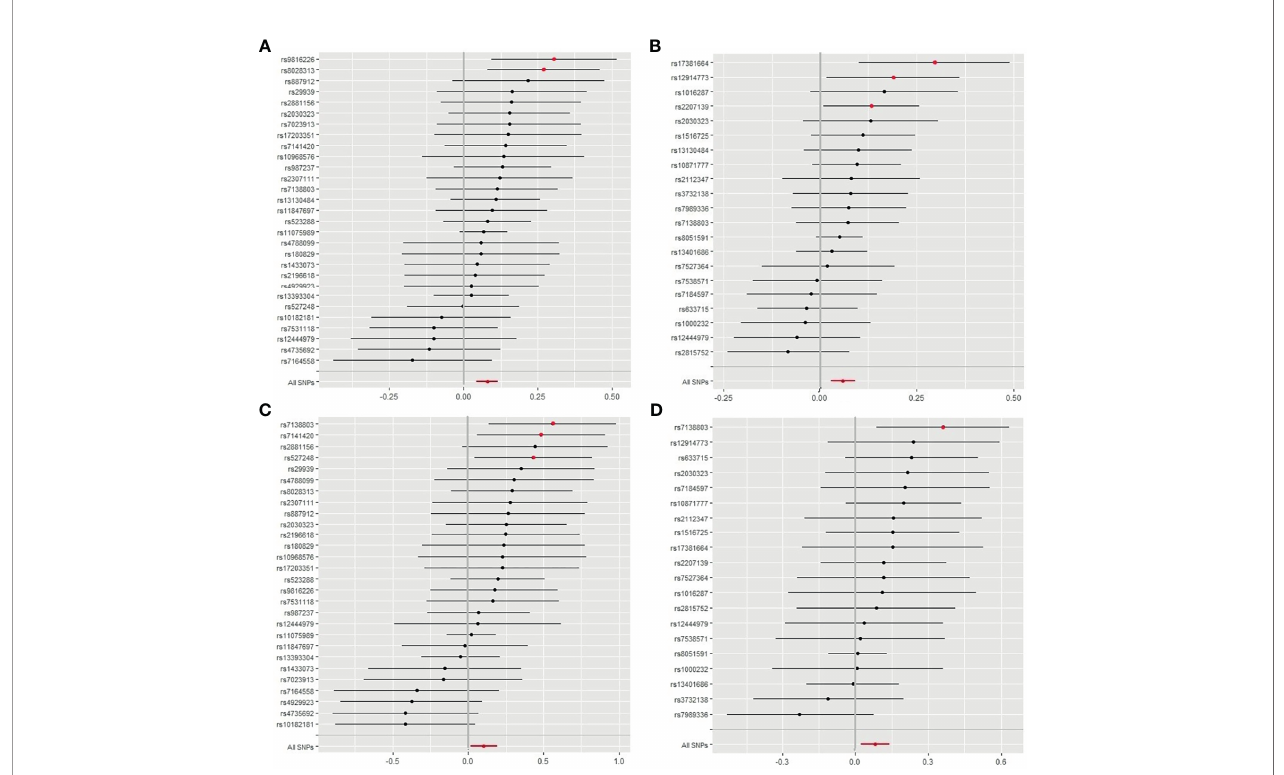
FIGURE 4 | Forest plot of SNPs of obesity classes I and II correlated with the risk of IS and CES. (A) The single effect of the SNPs in obesity class I and the risk of IS. (B) Single effects of the SNPs on obesity class II and the risk of IS. (C) Single effects of the SNPs on obesity class I and risk of CES. (D) Single effects of the SNPs on obesity class II and the risk of CES. IS, ischemic stroke; CES, cardioembolic stroke; SNP, single-nucleotide